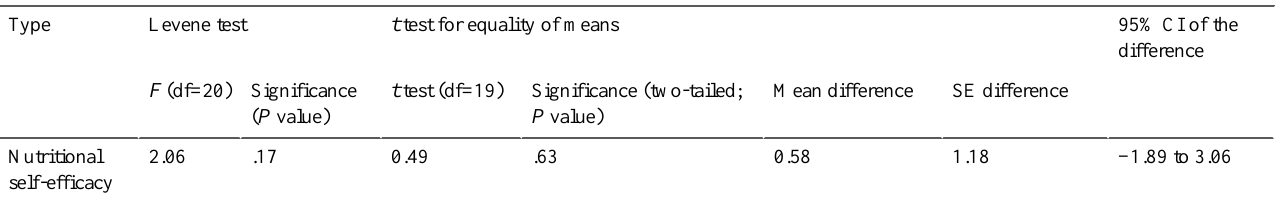
Table 8. Nutritional self-efficacy between-group